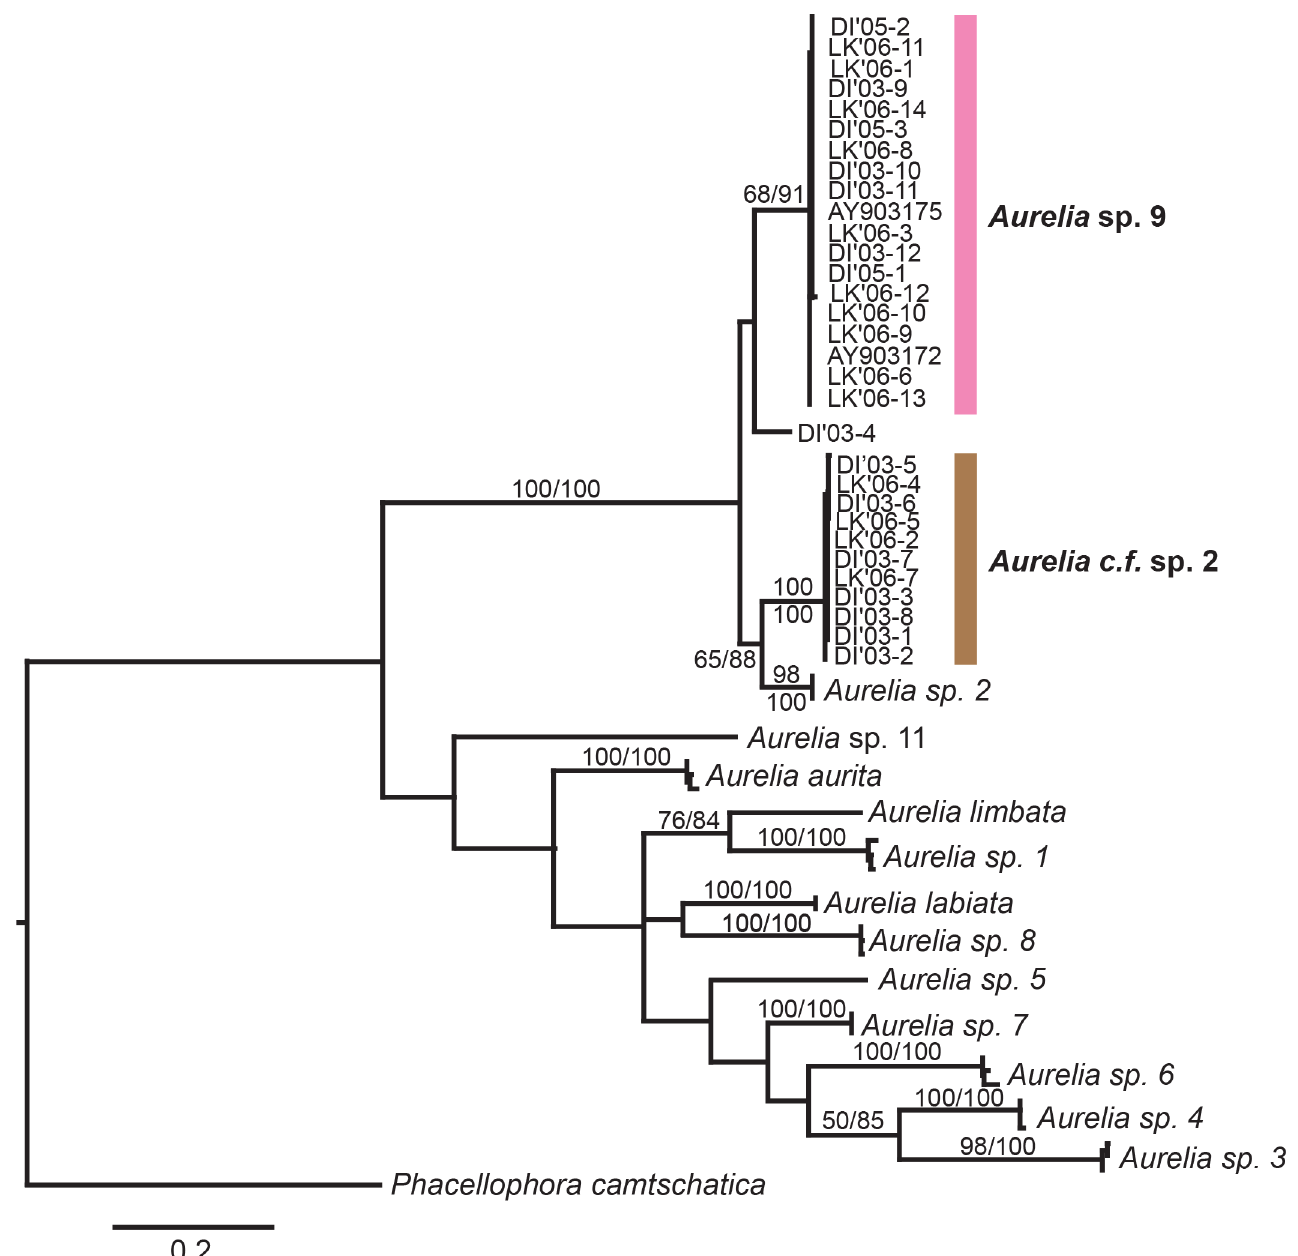
Fig 4. Global phylogeny of Aurelia based on cytochrome C oxidase subunit 1 ( COI ). Numbers indicate bootstrap values higher than 50% (maximum likelihood, 1,000 realizations). DI: Dauphin Island, Alabama. LK: Long Key, Florida. Sequences obtained in this study are shaded. The rest of sequences were obtained from GenBank (see S1 Table for details). Aurelia aurita (Turkey, Sweden, Boston-USA), 2) Aurelia labiata (British Columbia-Canada), 3) Aurelia sp. 1 (Los Angeles-USA, Australia, Japan), 4) Aurelia sp. 2 (Brazil), 5) Aurelia sp. 3 (Palau), 6) Aurelia sp. 4 (Hawaii- USA, Indonesia, Palau), 7) Aurelia sp. 5 (Mljet Lake, Croatia), 8) Aurelia sp. 6 (Palau, New Guinea), 9) Aurelia sp. 7 (Tasmania, Australia), 10) Aurelia sp. 8 (North Adriatic, Croatia), 11) Aurelia sp. 9 (Gulf of Mexico, USA; this study), 12) Aurelia limbata ( Aurelia sp. 10, Japan), 13) Aurelia sp. 11 (Marshall Islands), 14) Aurelia c.f. sp. 2 (Gulf of Mexico, USA; this study), 15) Aurelia sp. DI ’ 03 – 4 (Gulf of Mexico, USA; this